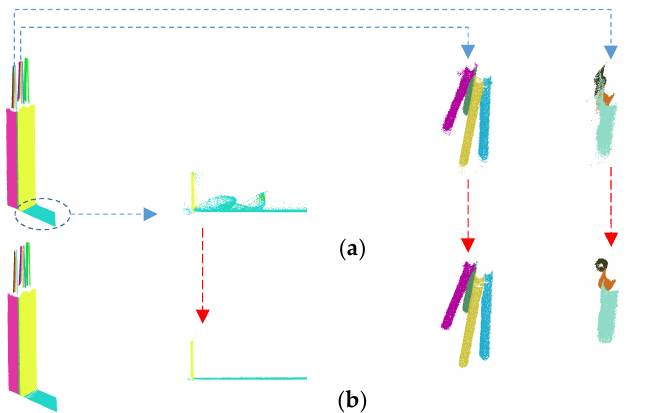
Figure 6. Comparison of type II errors during the point-to-model assignment: ( a ) scan vs. BIM with ε Const . = 100 mm and ( b ) proposed point cloud vs. model.